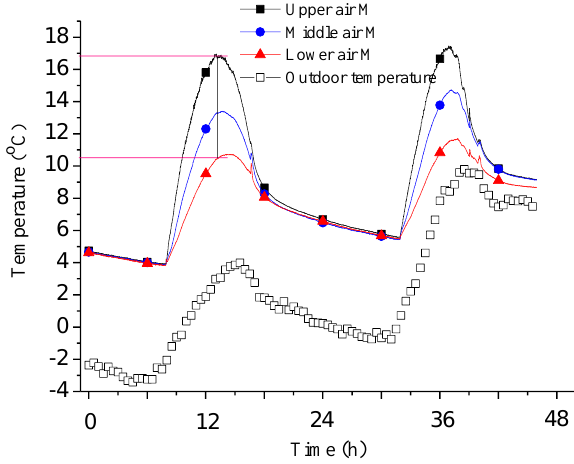
Figure 9. The air temperature distribution of test room and the ambient temperature.